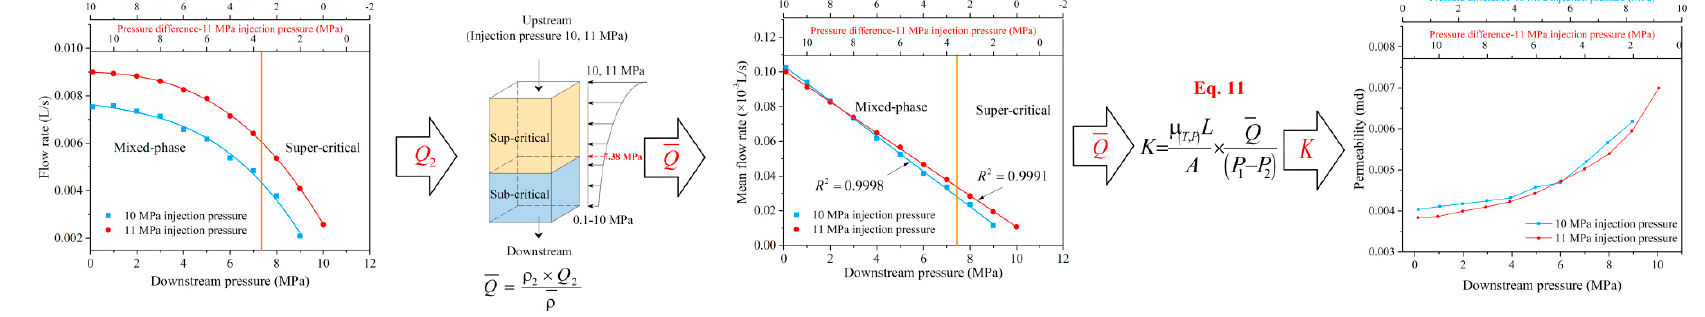
Figure 8. Mixed-phase CO 2 flow behavior and permeability variation at 20 MPa confining pressures.